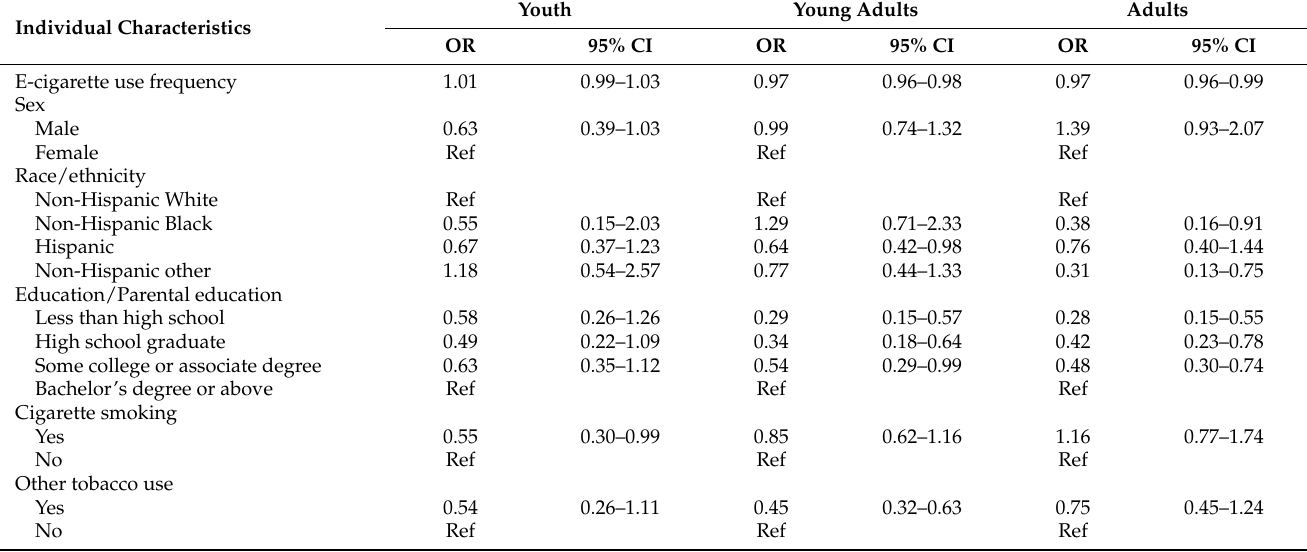
Table 1. Associations between JUUL use and e-cigarette use frequency, socio-demographic